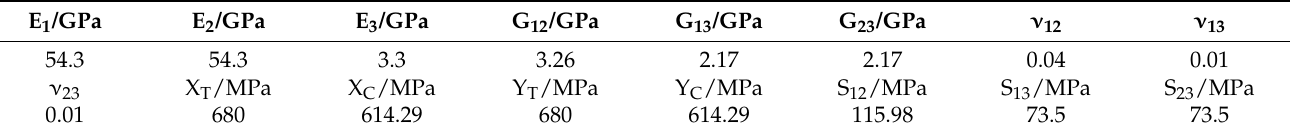
Figure 3. Finite element model. Table 4. Elastic engineering constants of materials [28].